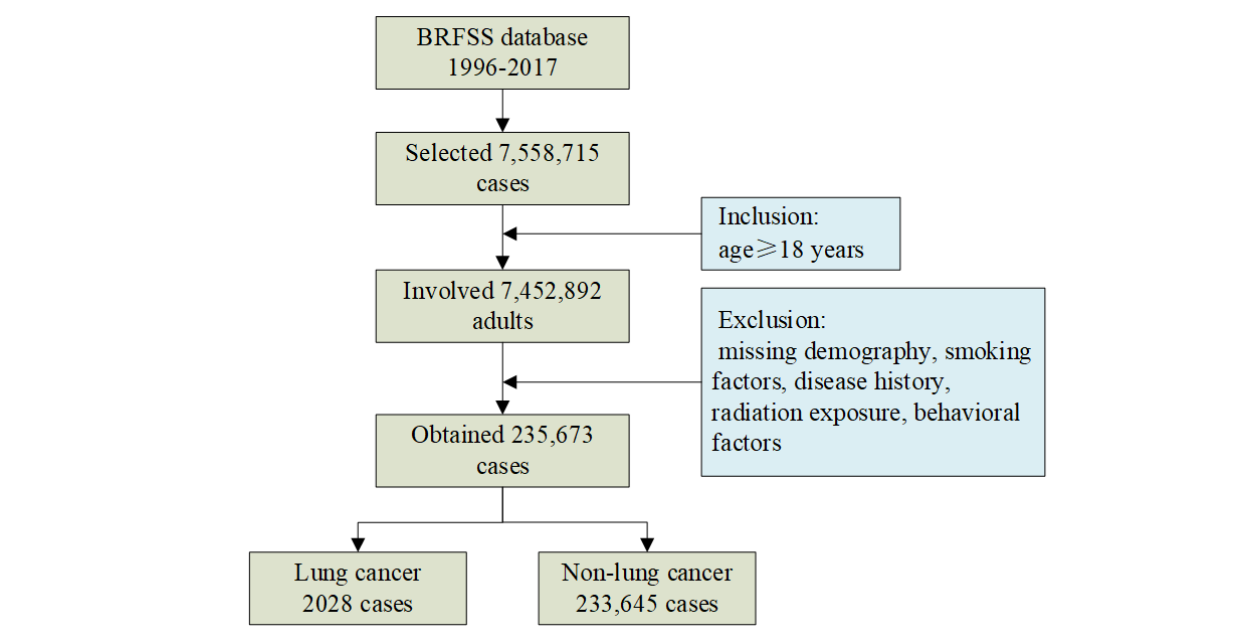
Figure 1. Data selection flowchart. BRFSS: Behavioral Risk Factor Surveillance System.